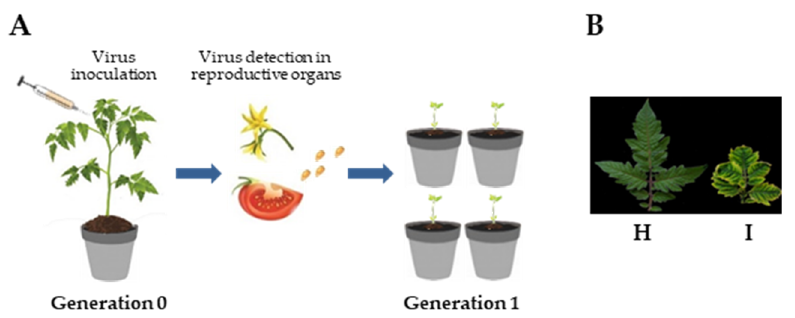
Figure 1. Analysis of the seed transmissibility of TYLCSV in tomato plants. ( A ) Scheme of the experiment to investigate the presence of TYLCSV in tissues of reproductive organs of agroinfected plants (Generation 0) and its transmissibility to progeny plants (Generation 1). ( B ) Tomato yellow leaf curl disease symptoms on tomato leaves at 6 weeks post-inoculation (H, healthy; I, infected).